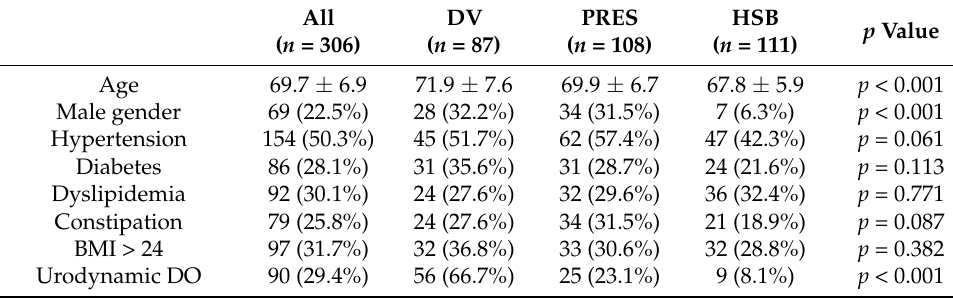
Table 1. Patients’ demographics.